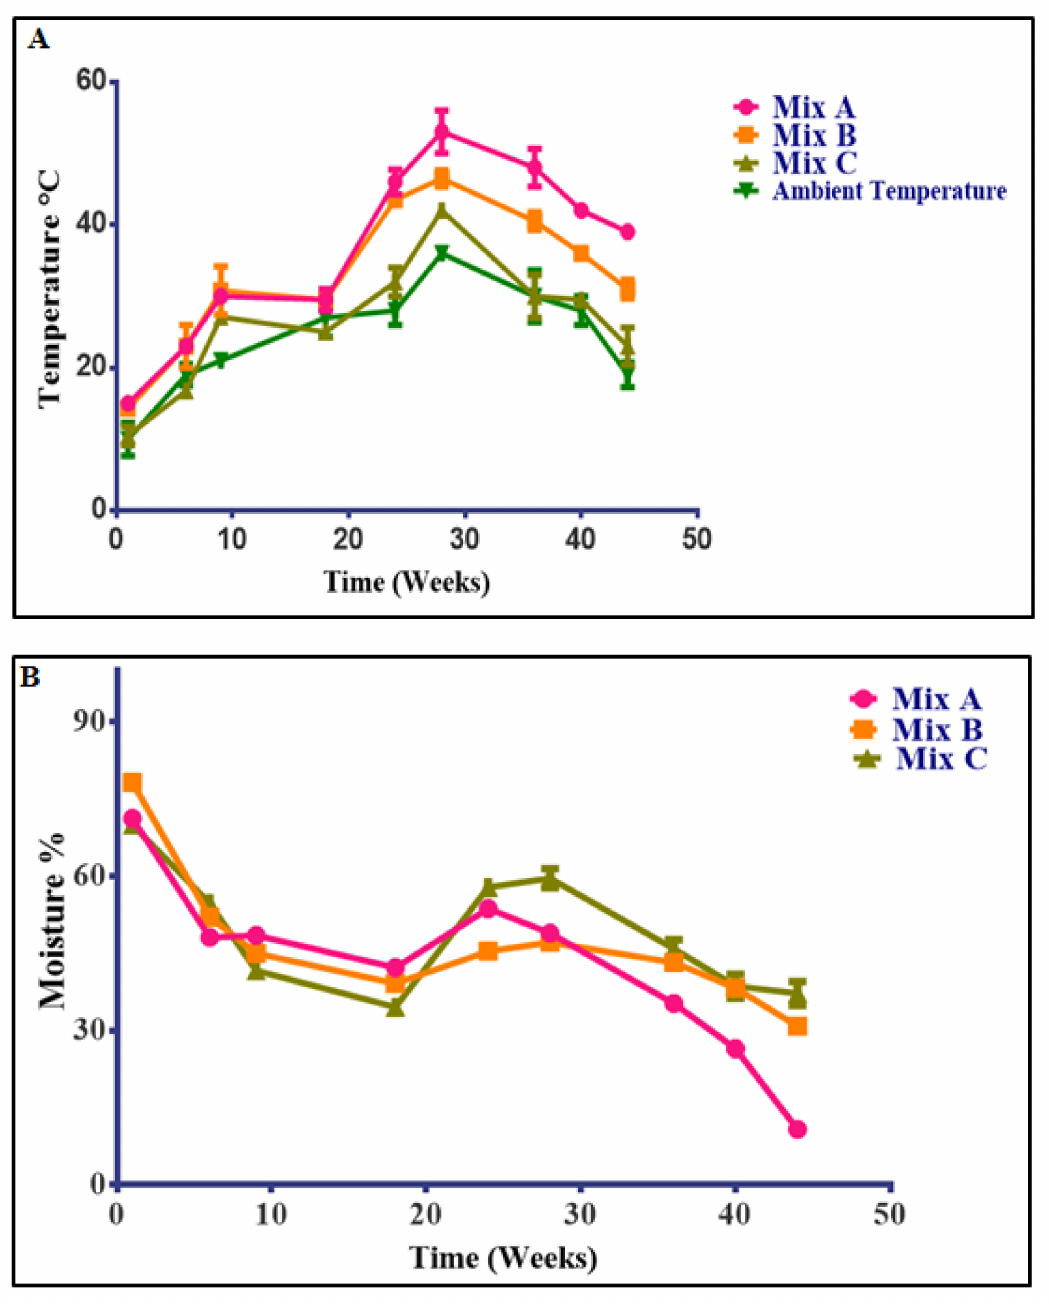
Figure 2. Changes in temperature ( A ) and moisture ( B ) during the composting of di ff erent